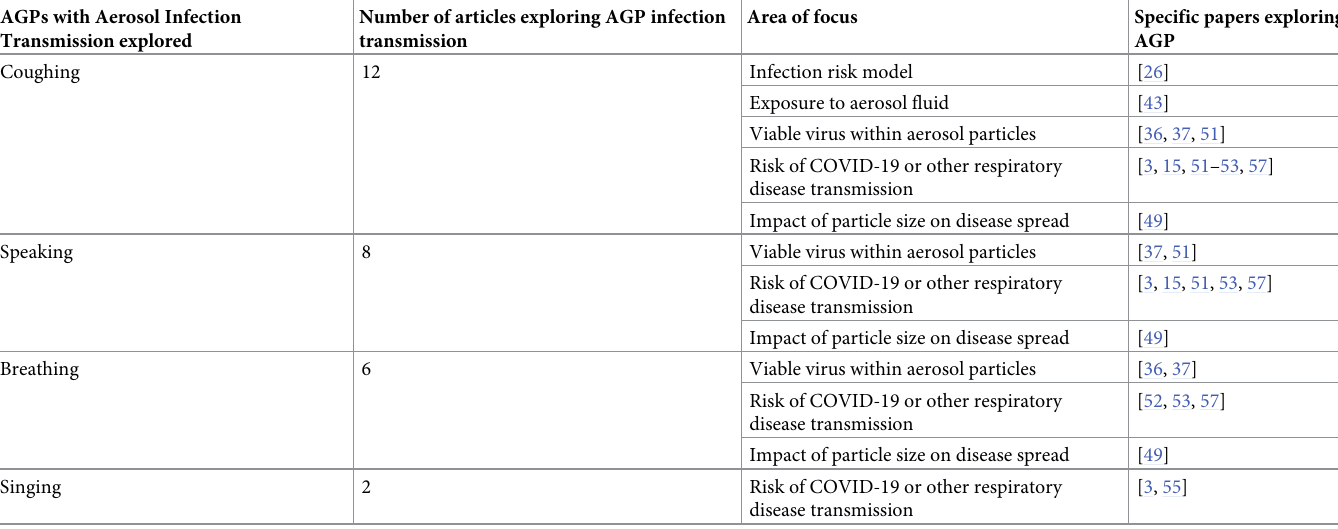
Table 4. Records examining risk of infectious transmission of aerosols across